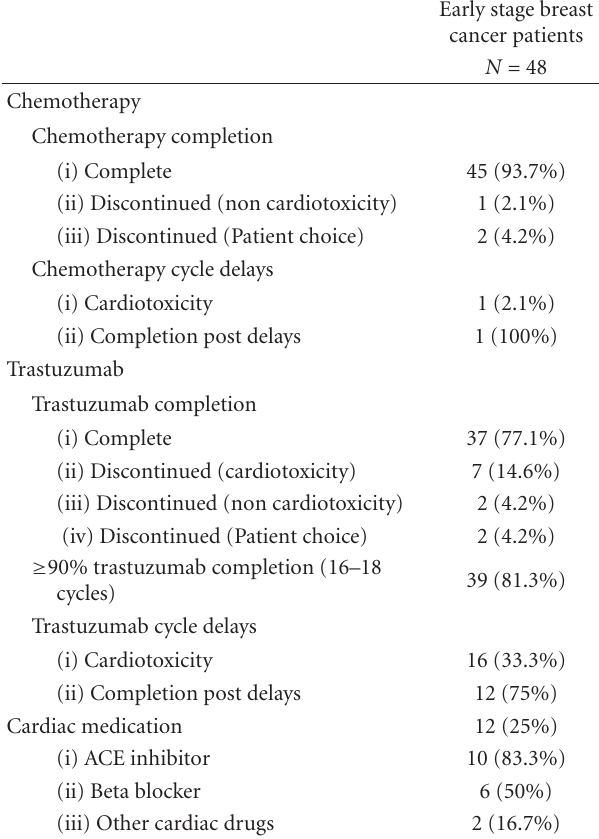
Table 2: Treatment regimens.